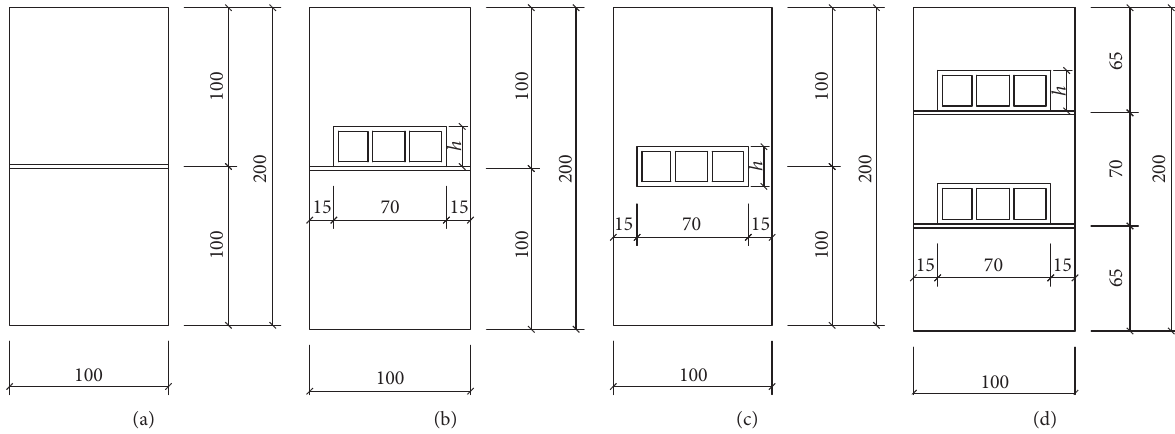
Figure 3: Arrangement of reinforcement schemes in the tests (dimensions are in mm): (a) geogrid sheet, (b) geogrid cell, (c) one layer of combination 3D reinforcement, and (d) two layers of combination 3D